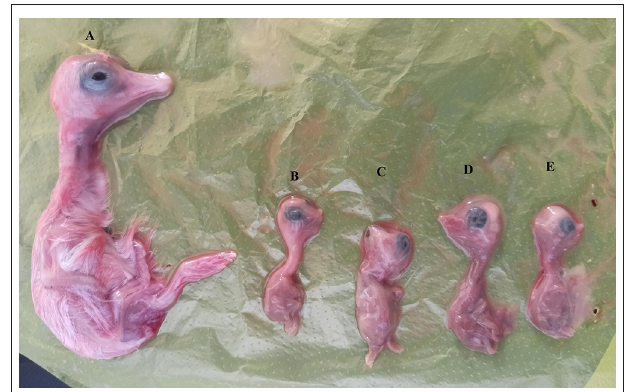
FIGURE 6 | Pathological changes in goose embryos infected with CHSH01 in 7-day post infection. (A) Noninfected goose embryo control. (B–E) Infected goose embryos showing severe growth retardation and body